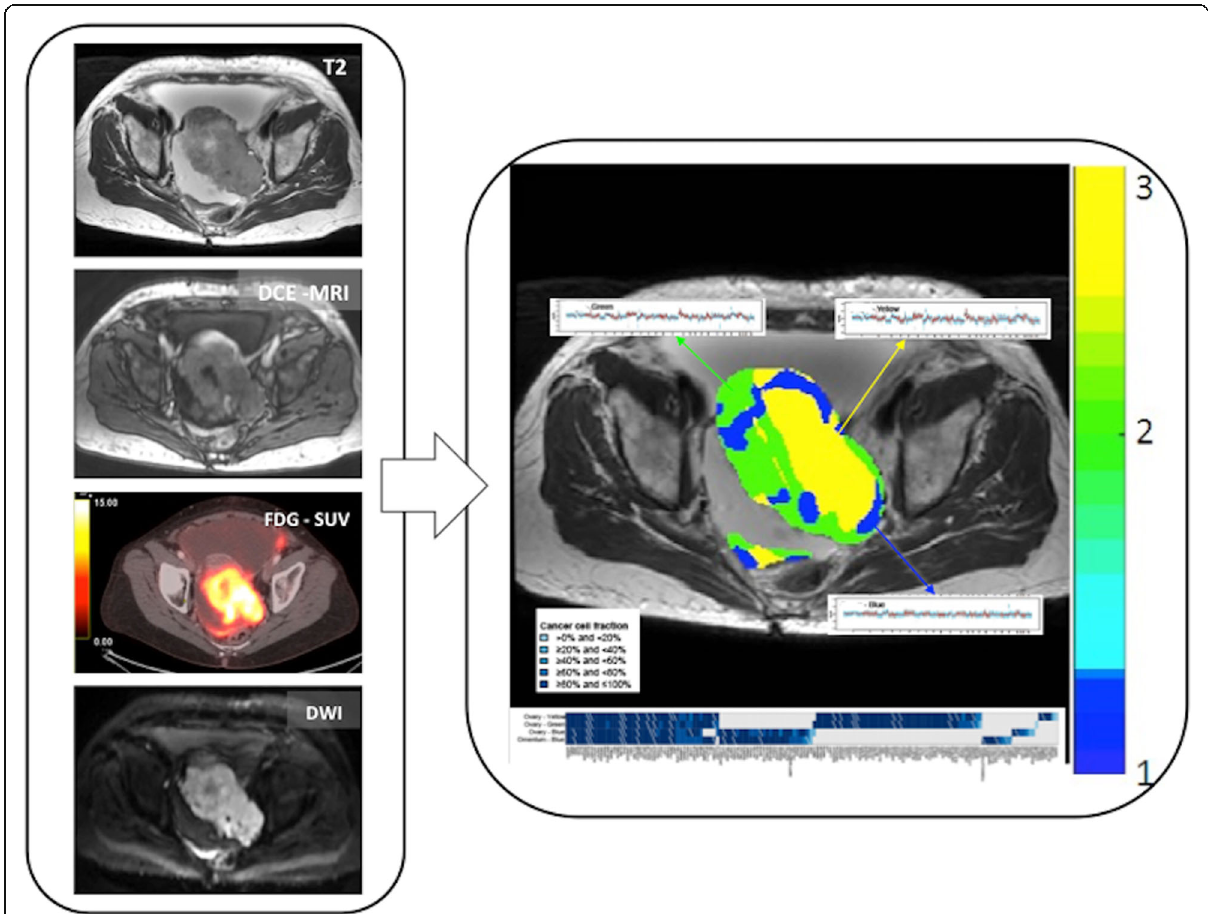
Fig. 20 A 70-year-old woman with high-grade serous ovarian cancer who underwent FDG-PET/CT (standardized uptake value map of the fluorodeoxyglucose uptake [FDG SUV] is showed) and MRI, which included T2, diffusion (DWI), and dynamic contrast-enhanced (DCE) sequences (images on the left) showing a primary ovarian mass as well as multiple peritoneal/serosal implants including in the cul-de-sac. A composite “ habitat ” map of the implant in the cul-de-sac was performed (right) containing three clusters derived from PET and MRI data. Tissue sampling from each cluster represented by a different color on the habitat map demonstrated genomic heterogeneity underpinning the phenotypic heterogeneity observed on